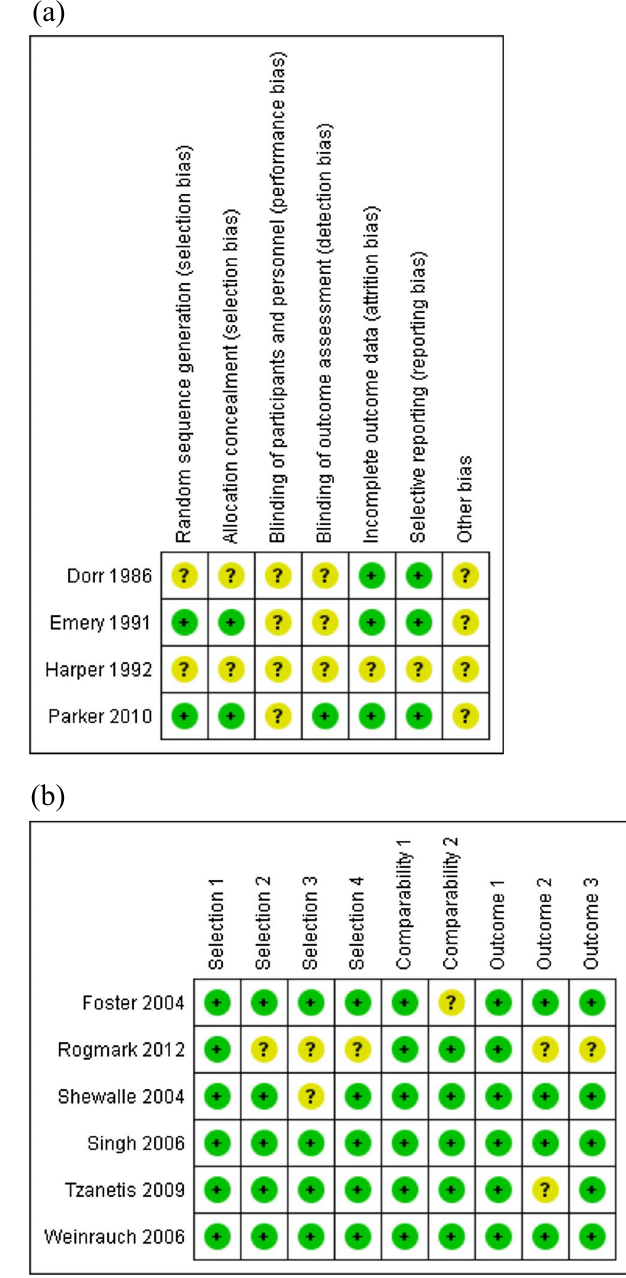
Figure 2. (a) Risk of bias summary of randomized clinical trials; (b) Risk of bias summary of observational